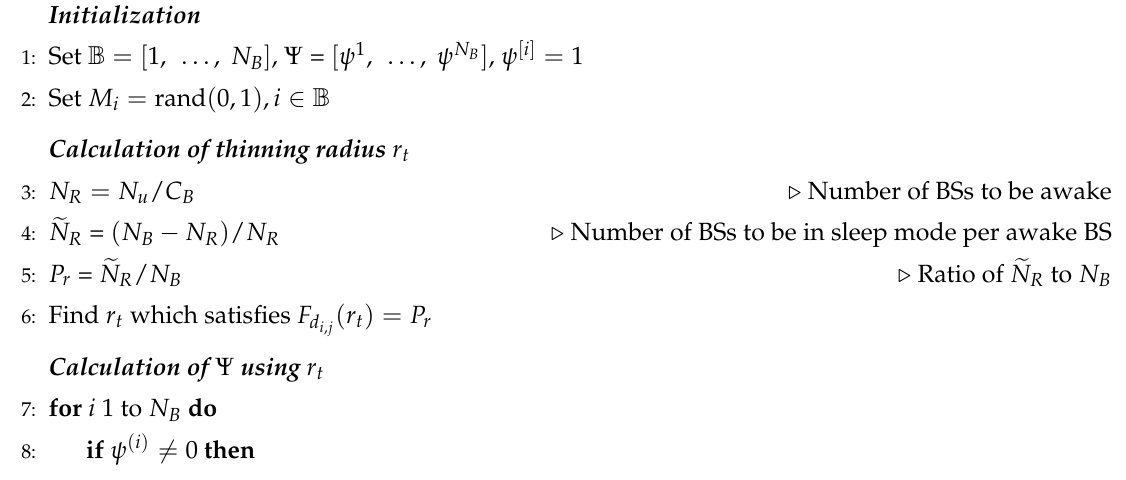
Algorithm 1 Approximate Thinning Based Judicious Network Control Algorithm.